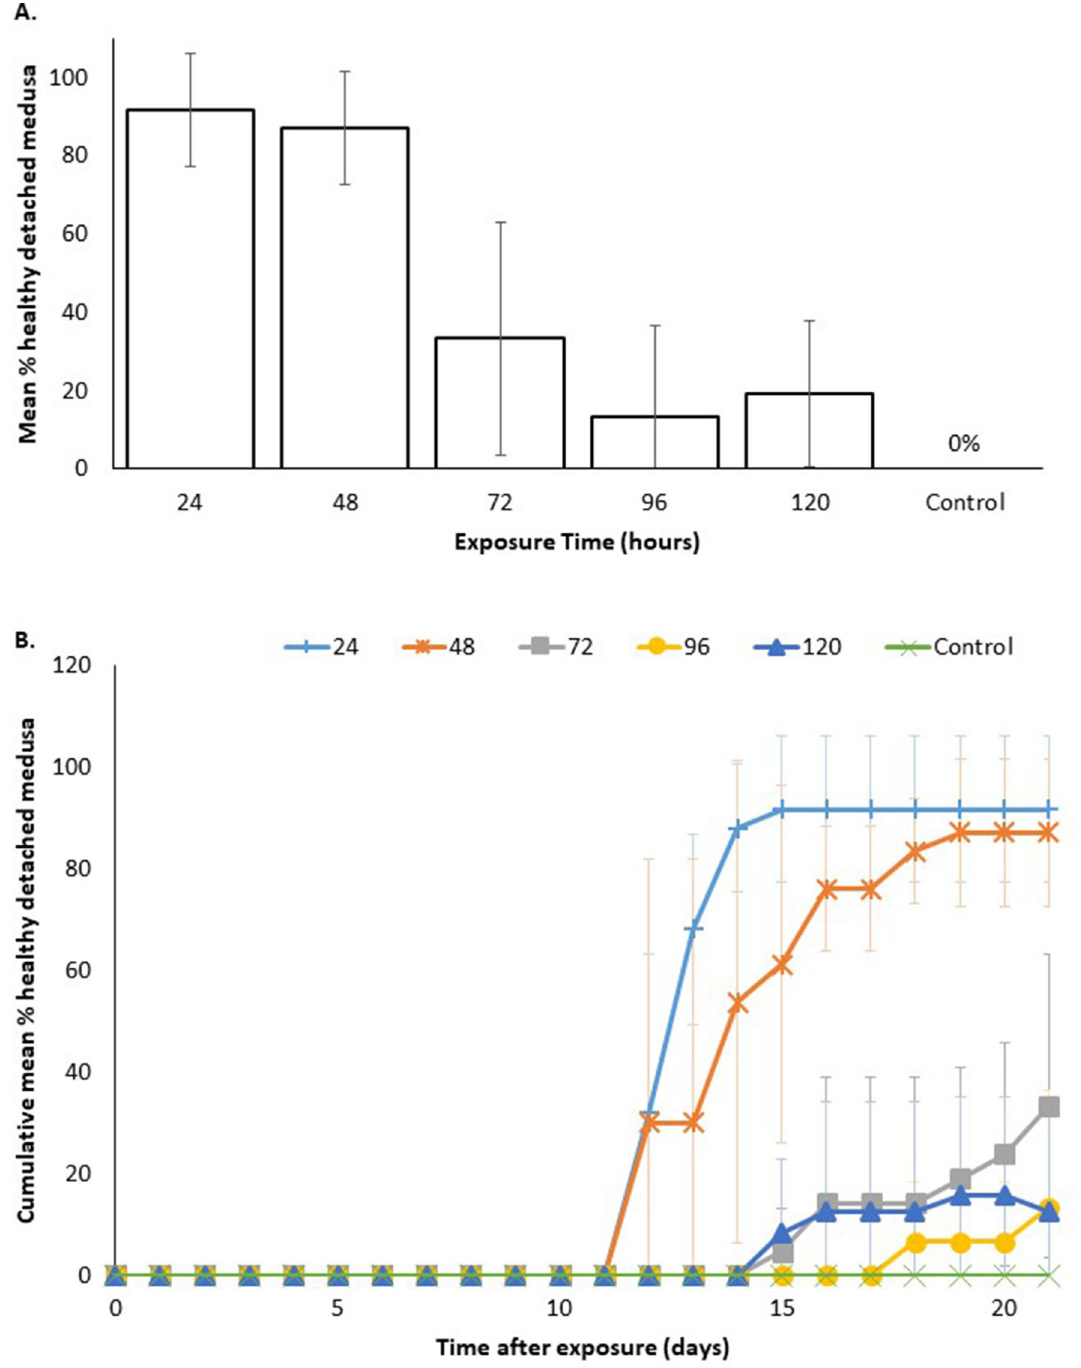
Figure 5. ( A ) Total Mean percentage (± SD error bars) after 21 days of healthy medusas produced by Carukia barnesi polyps exposed to 5-methoxy-2-methylindole at 1 μM for different time periods. Exposure time (hours) before solution was changed out to seawater only. Control is seawater only. ( B ) Cumulative mean percentage (± SD error bars) of detached healthy medusas over a 21 day period following exposure to 5-methoxy-2- methylindole at 1